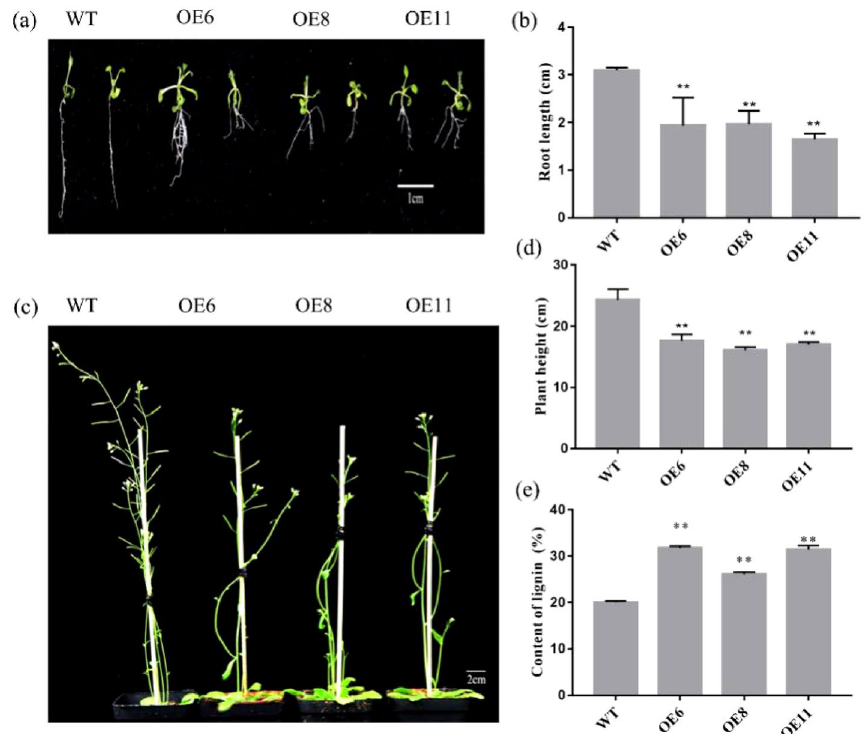
Figure 5. Identification of transgenic Arabidopsis positive seedlings and determination of the biomass from WT and PbCSE1 transgenic Arabidopsis plants. ( a ) The root length of PbCSE1 after 7 d. ( b ) The statistics of root length after 7 d. ( c ) Plant height of PbCSE1 after 5 weeks. ( d ) The statistics of plant height after 5 weeks. The asterisks indicated values that were determined by the t-test to be significantly different from their equivalent control (** P < 0.01). ( e ) The lignin content in the WT and overexpressing Arabidopsis